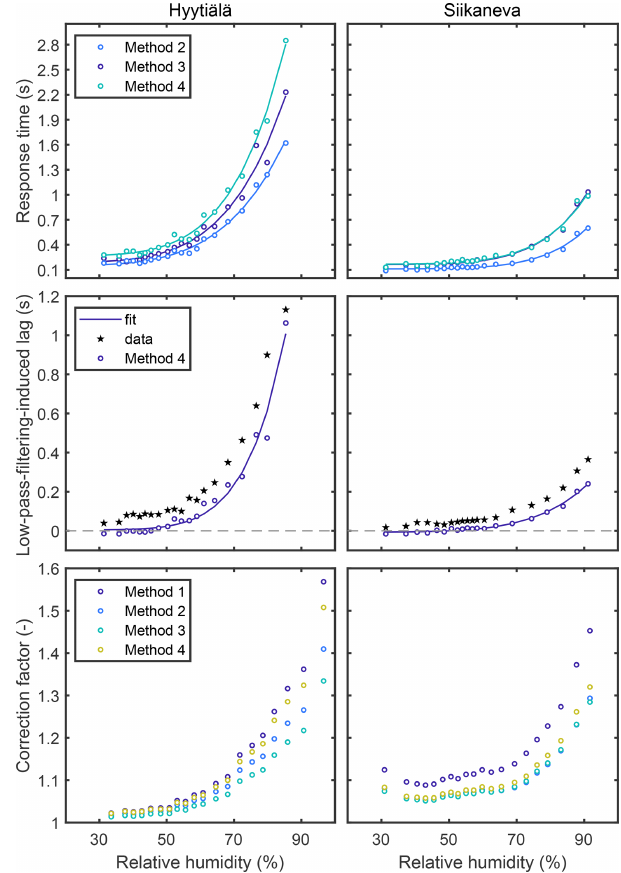
Figure 9. Response times (top row), low-pass-filtering-induced time lags (middle row) and correction factors (bottom row) as a function of relative humidity. Results for Hyytiälä pine forest are on the left and for Siikaneva open peatland on the right. The lines describe the fits used to obtain τ and t lpf values for the CF calcula- tion (see Sect.